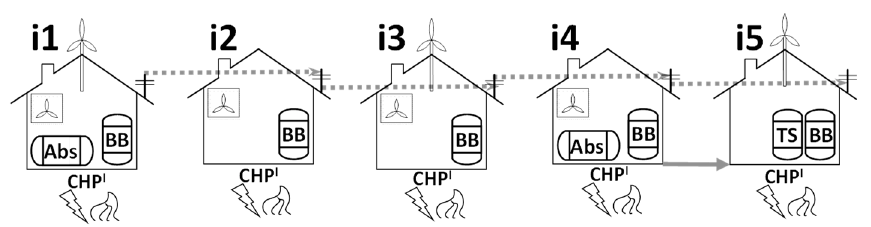
Figure 5. Design of the Unset scenario network based on dynamic export pricing.